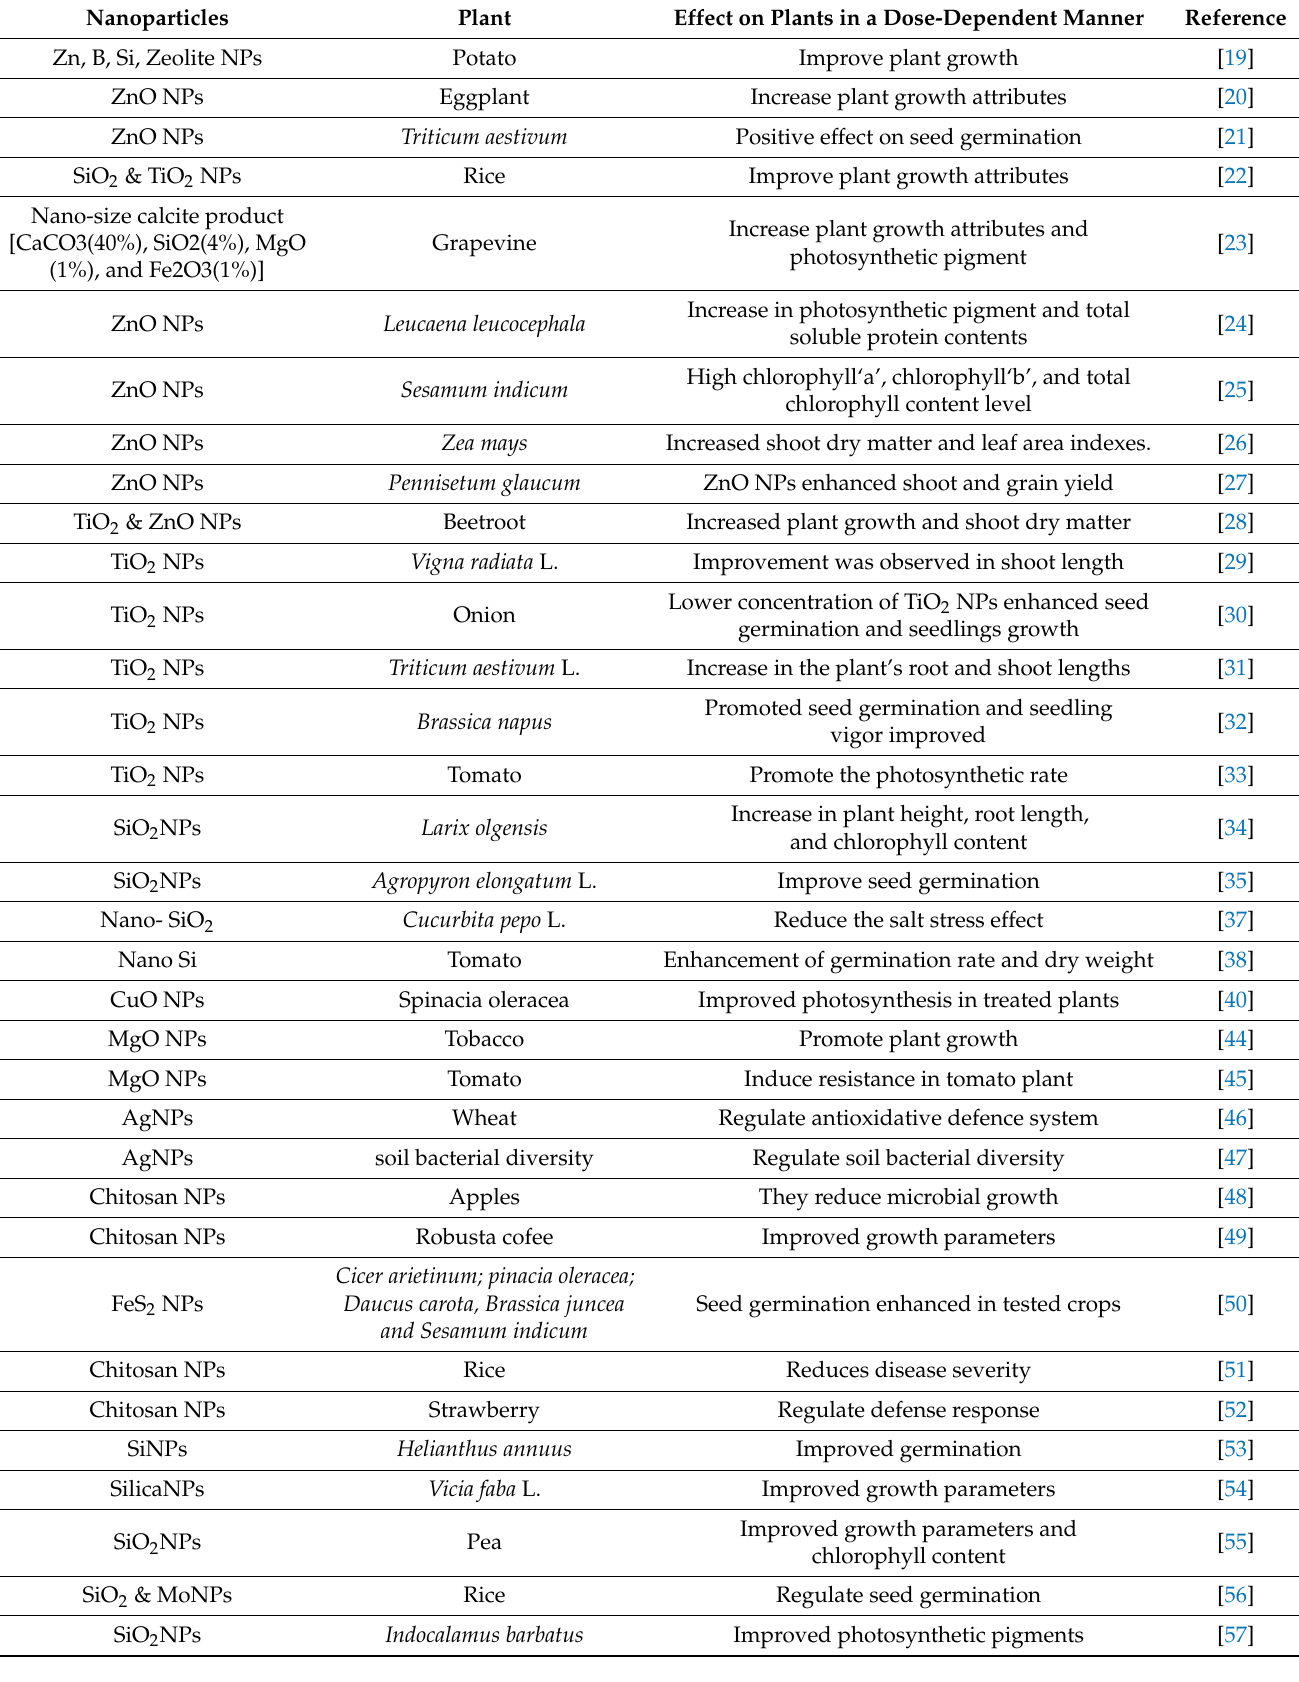
Table 1. Effect of various nanomaterials on plant physiology and growth